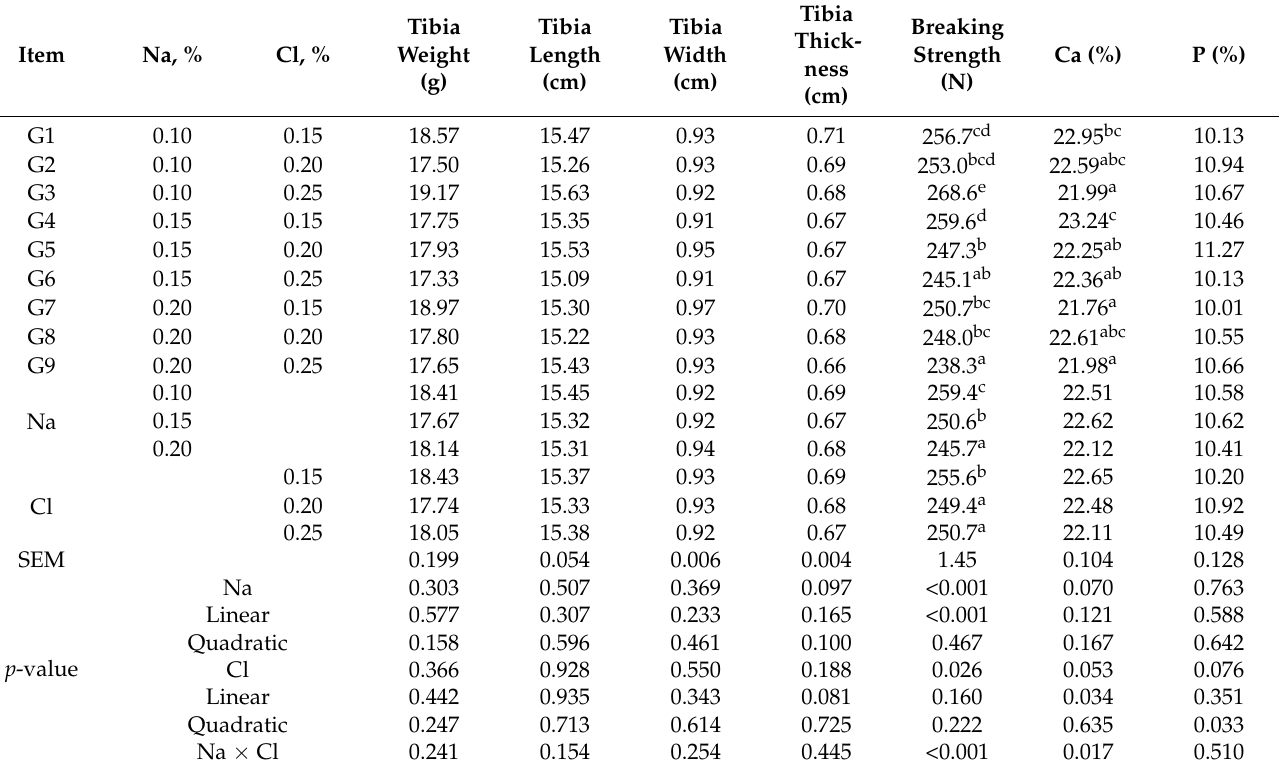
Table 5. Effects of dietary Na and Cl on tibial quality of 70-day-old geese ( n =